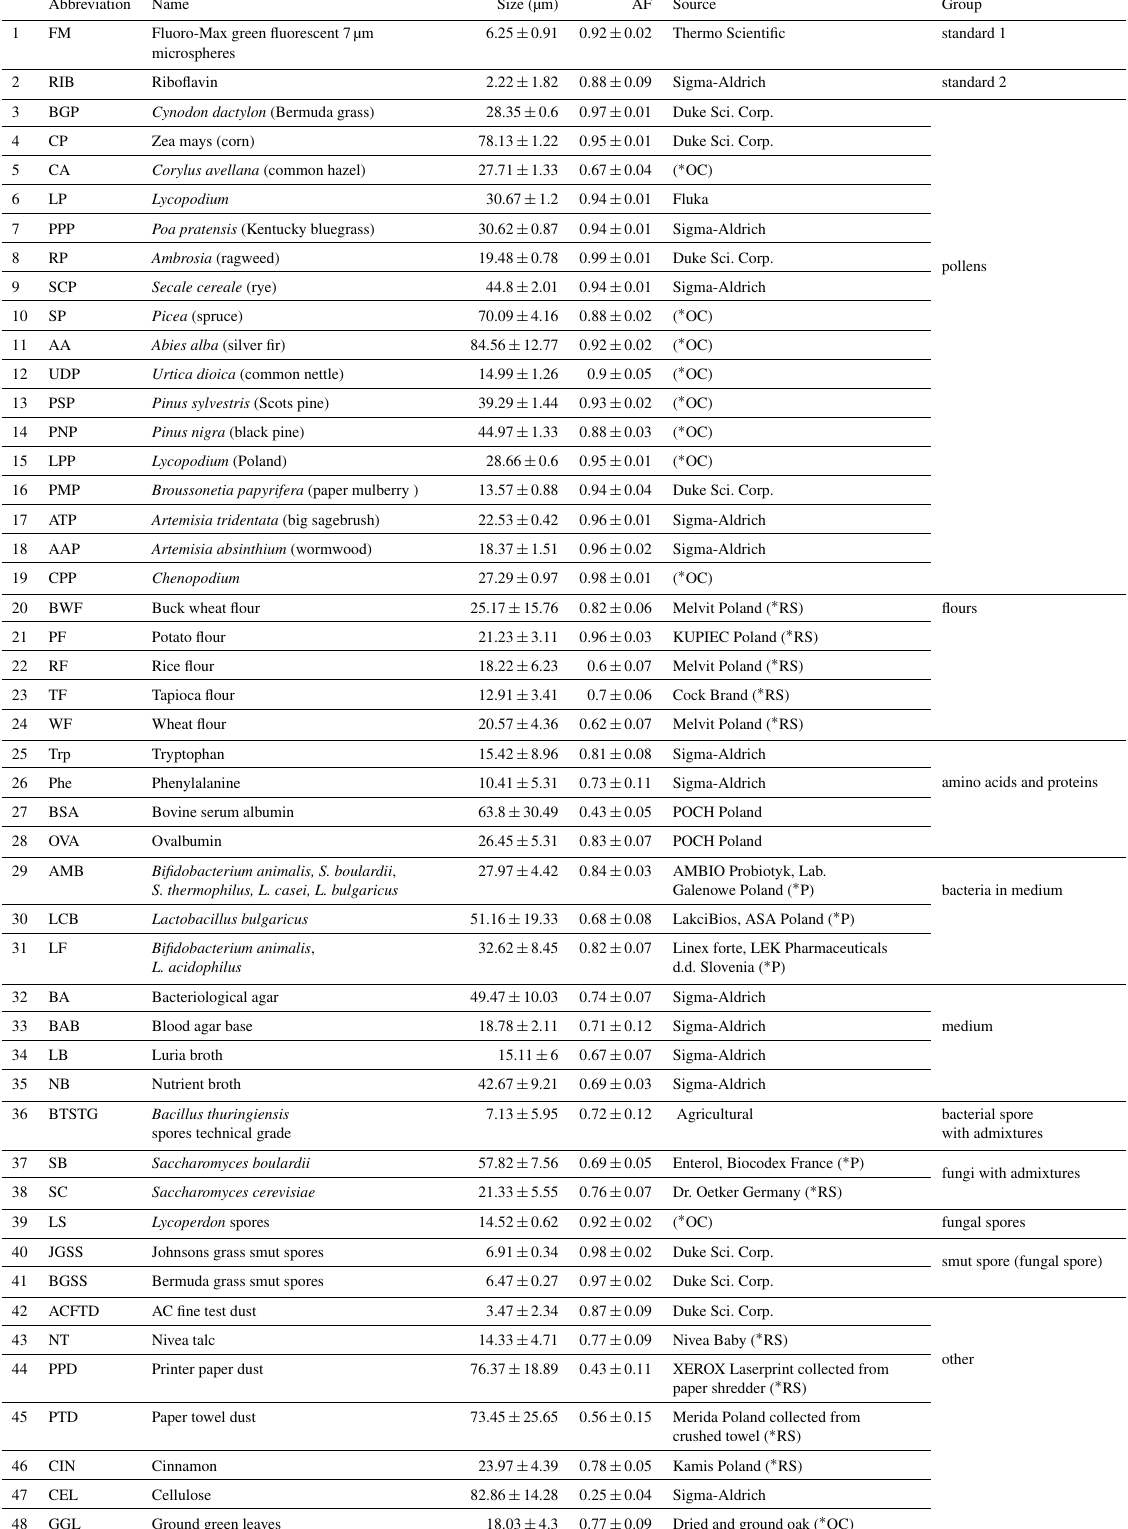
OC:pollenscollectedfromtrees,flowersandgrassintheregionofWarsawduringvegetativeseasonsin2015and2016. ∗ RS:regularshopsinWarsawwherecommongoodsarepurchased. ∗